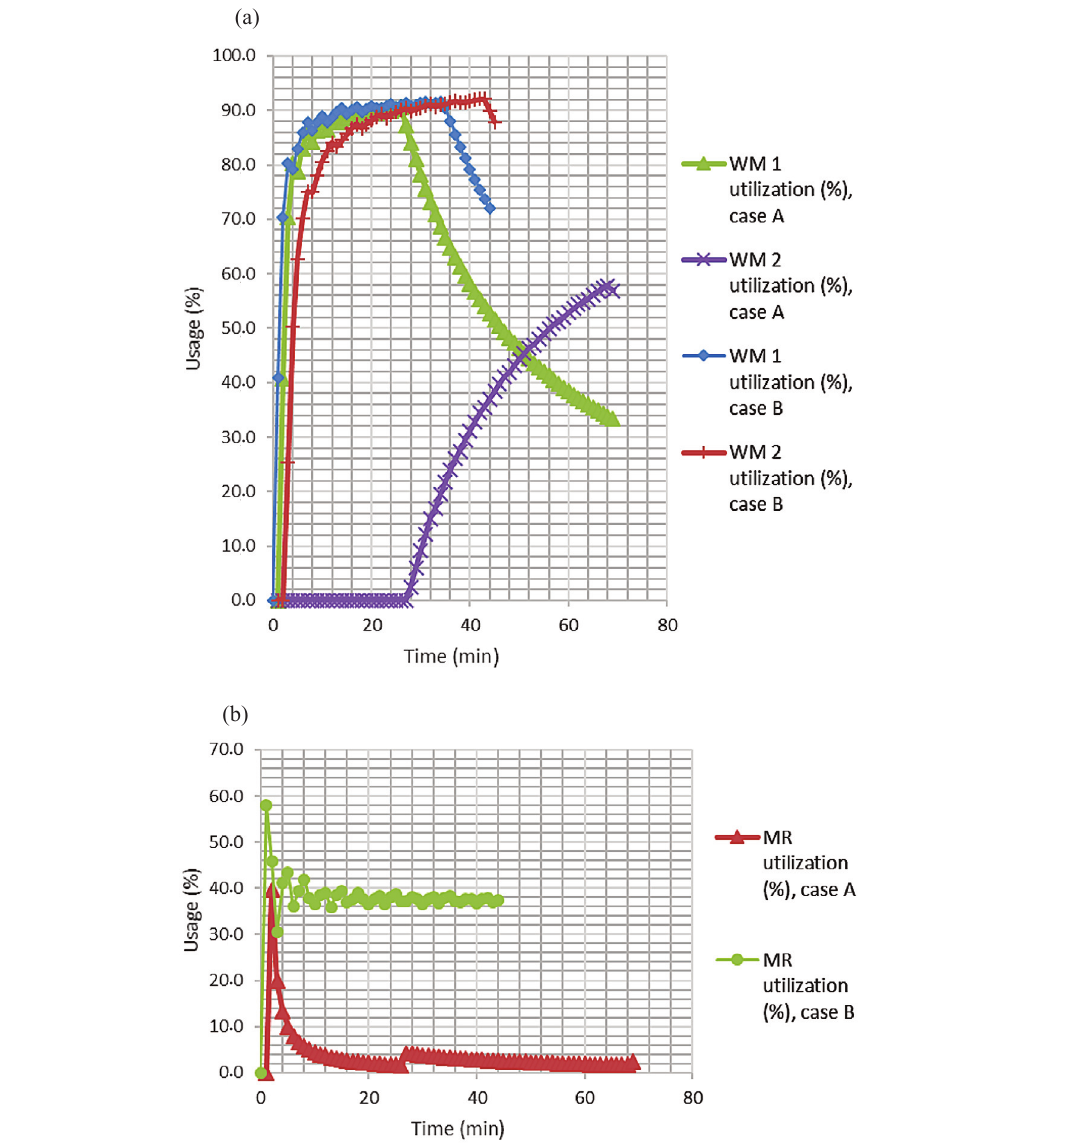
Fig. 3. Working machine utilization (a) and mobile robot utilization (b).